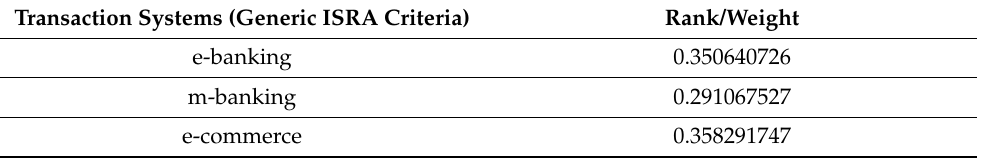
Table 12. Rank of transaction systems according to generic ISRA criteria. Transaction Systems (Generic ISRA